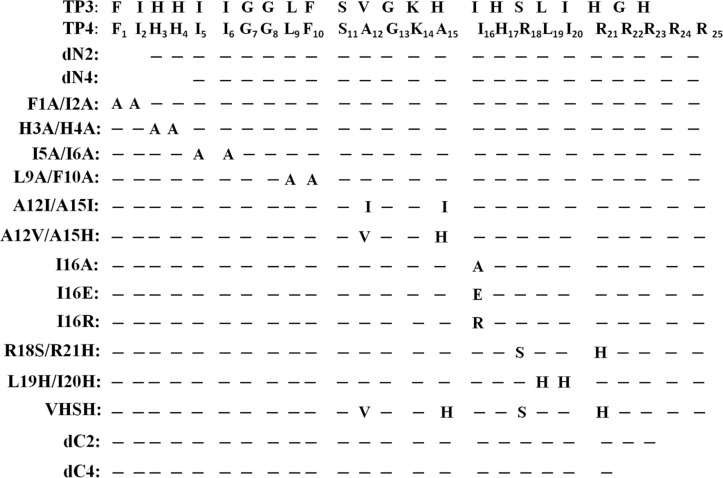
Amino acid sequences of TP3 and TP4-derived peptides.Dashed line indicates the residue identical to that of wild type TP4.